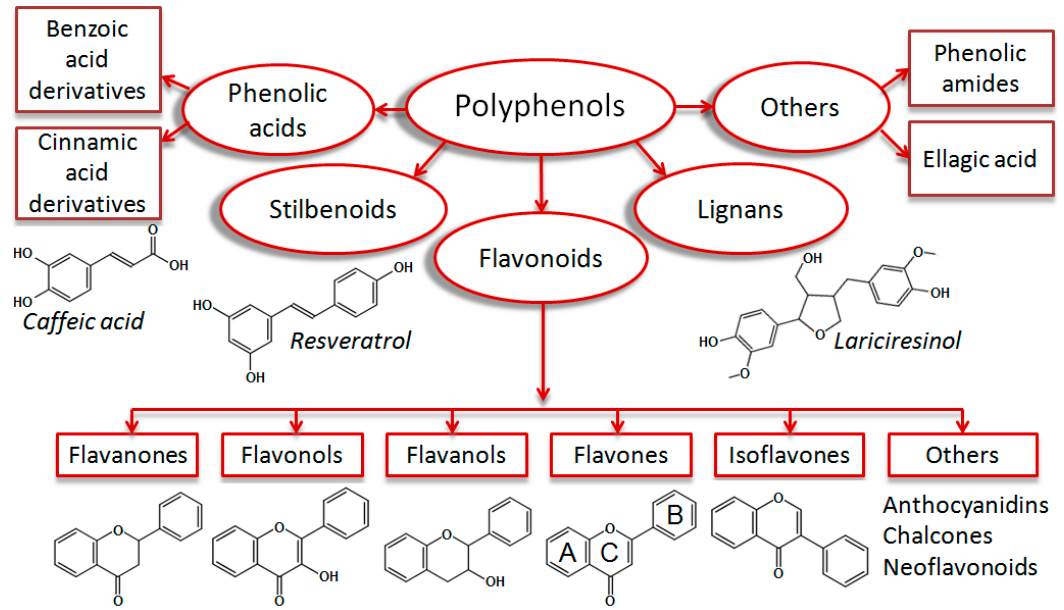
Figure 1. Classification of monomeric polyphenolic compounds according to Zhang et al. 2016 [2], with some modifications. Polyphenols are plant-derived compounds of four main structural subclasses: Phenolic acids, stilbenoids, flavonoids, and lignans. Phenolic acids are derivatives of benzoic or cinnamic acids (i.e., caffeic acid). Stilbenoids are hydroxylated stilbene derivatives (i.e., resveratrol). Lignans are diphenolic compounds (i.e., lariciresinol). Flavonoids are phenylchromone derivatives, which are subgrouped into flavanones, flavonols, flavanols, flavones, isoflavones, and others (anthocyanidins, chalcones, and neoflavonoids). Some authors classify phenolic amides (i.e., capsaicin) and ellagic acid derivatives [3] as additional polyphenol groups.